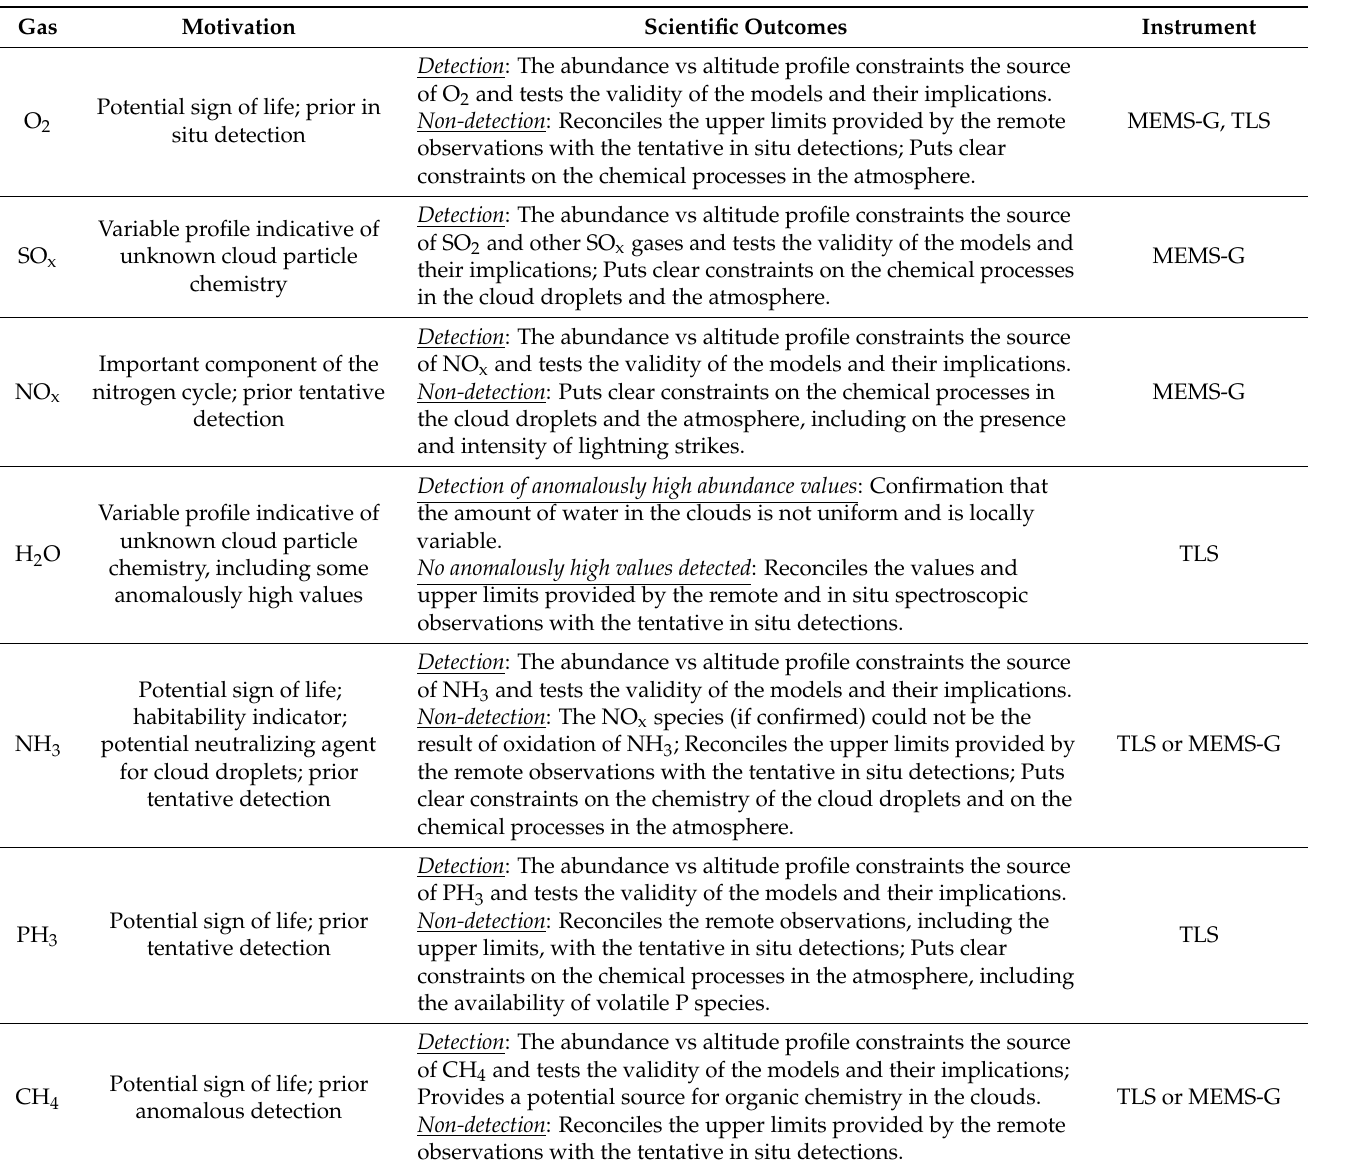
Table 3. Gases of interest. TLS = tunable laser spectrometer, MEMS-G = MEMS gas molecule analyzer. See also [9] for the detailed discussion of the Venusian atmospheric anomalies, including anomalous gas